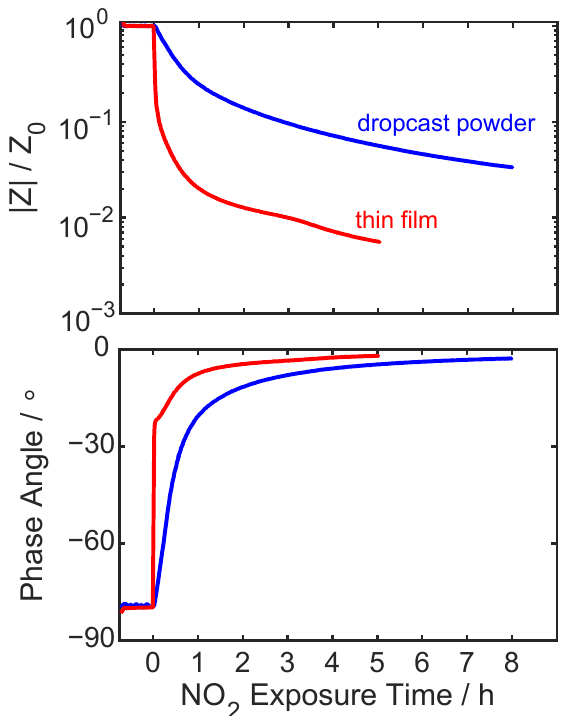
Figure 7. Comparison of the electrical impedance (100 mHz) over time of an IDE with a Ni-MOF-74 MOF thin film membrane grown on it versus an IDE with bulk Ni-MOF-74 powder dropcast onto it. Both IDEs were exposed to 5 ppm NO 2 in N 2 at 50 °C.